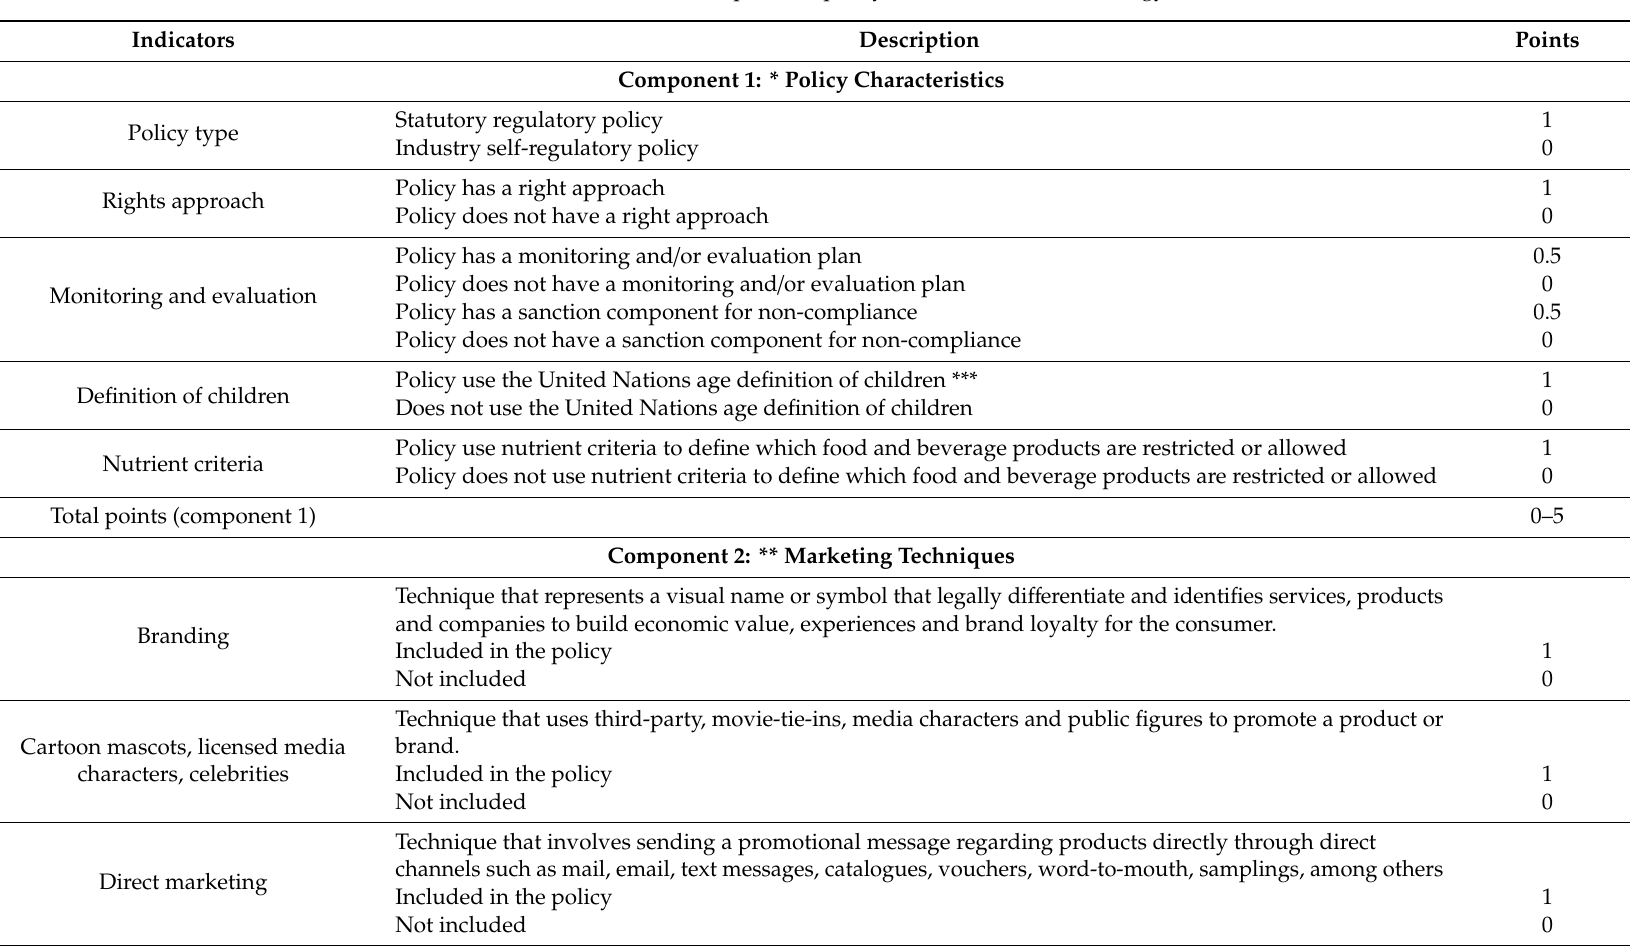
Table 1. Overview of the responsible policy index (RESPI)